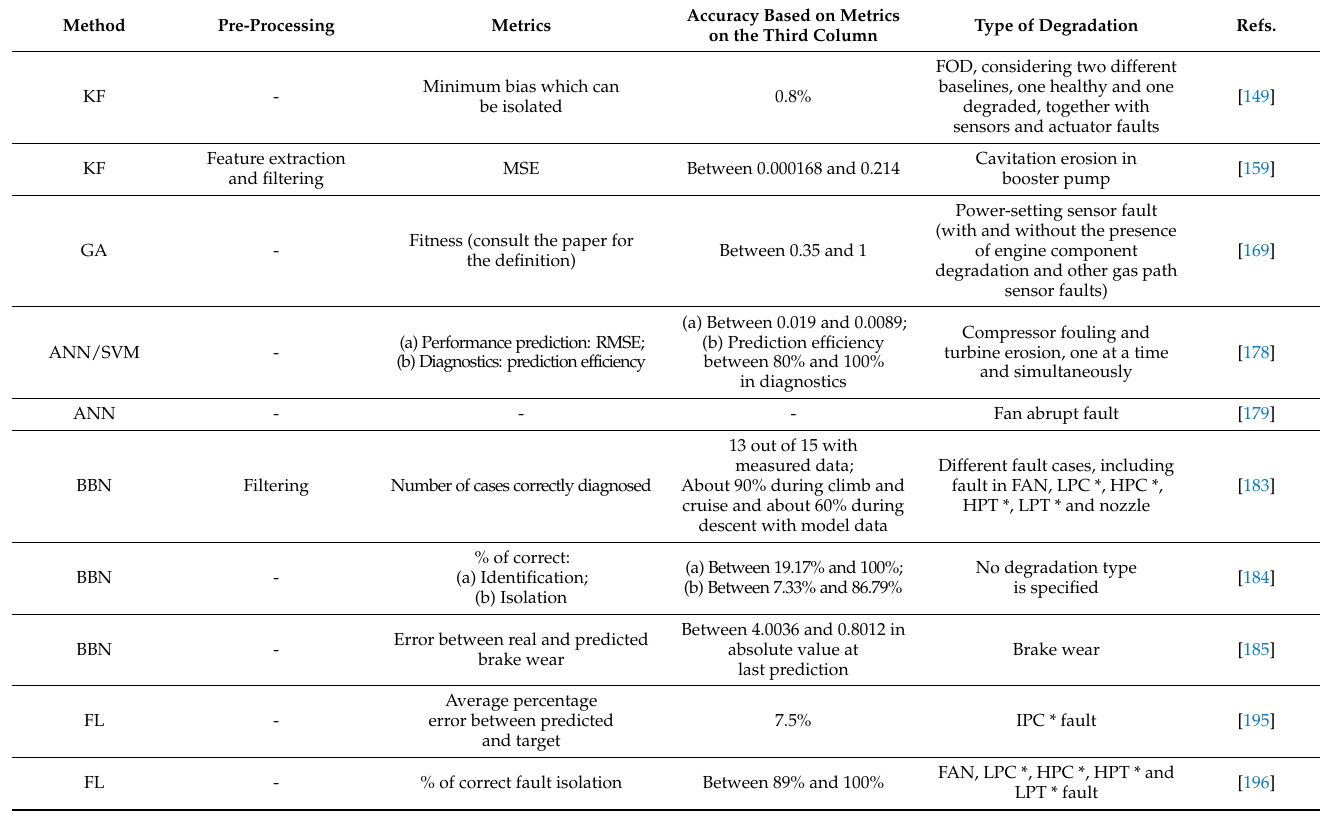
Table 8. List of some works present in the literature with relative characteristics. For a more detailed description, read the corresponding references. Continuation of Table